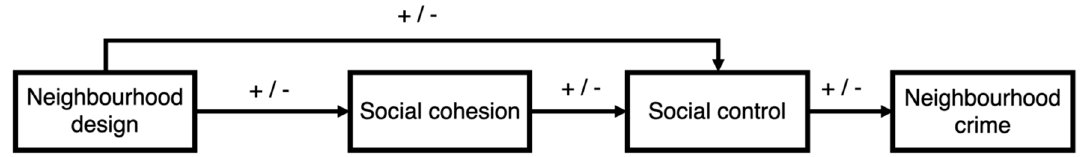
Figure 4. Pathway model illustrating the purported influence of neighbourhood design on CE (social cohesion and social control) and social control directly.